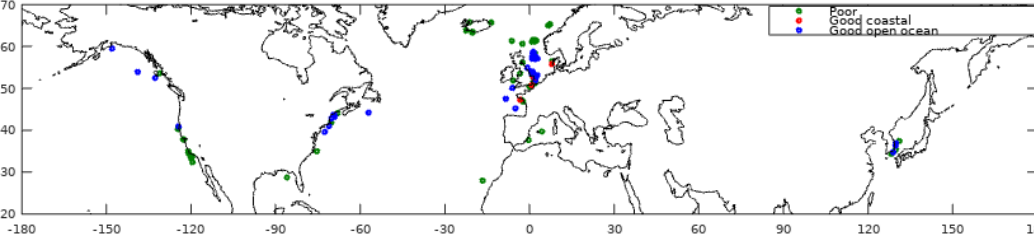
Figure 12. Locations of buoy-altimeter matchups. Red shows locations with good correlation in coastal region (less than 15 km from coast); blue for open ocean. Green marks those with poor